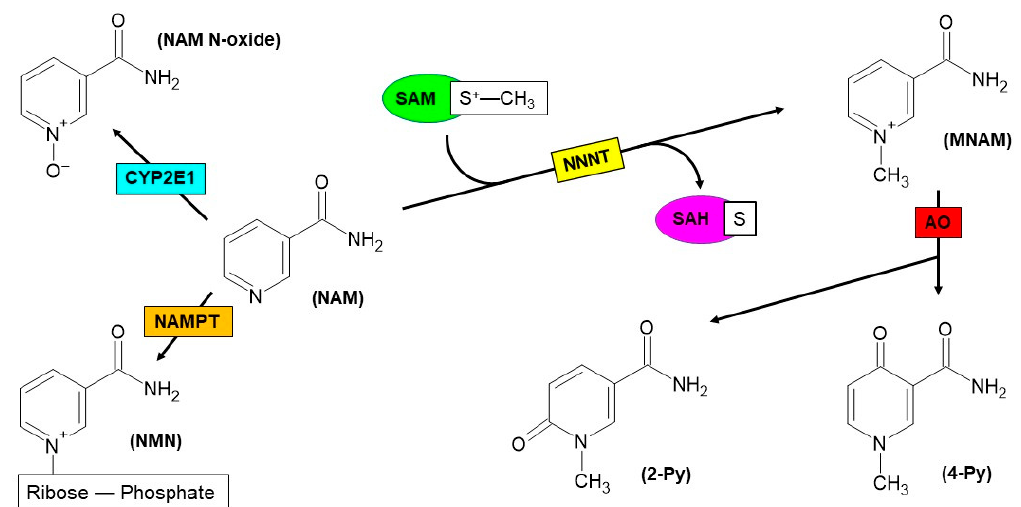
Figure 2. Reactions featuring different fates of nicotinamide (NAM). NAM is first subjected to methylation of nitrogen within the pyridine ring, via the catalysis of nicotinamide N -methyltransferase (NNMT) enzyme. S-adenosyl-L-methionine (SAM) is used as a methyl donor and further is converted to S-adenosyl-L-homocysteine (SAH) upon catalysis. Subsequently, N1-methylnicotinamide (MNAM) can act as a substrate of aldehyde oxidase (AO), leading to the formation of oxidation products, such as N1-methyl-2-pyridone-5-carboxamide (2-Py) or N1-methyl-4-pyridone-3-carboxamide (4-Py). An alternative catabolic pathway for NAM is represented by N-oxidation, in which the substrate is oxidized to nicotinamide N -oxide (NAM N -oxide) through the activity of Cytochrome P450 2E1 (CYP2E1) enzyme. In the first step of NAD + biosynthesis, NAM acts as a substrate of nicotinamide phosphoribosyltransferase (NAMPT), yielding nicotinamide mononucleotide (NMN).